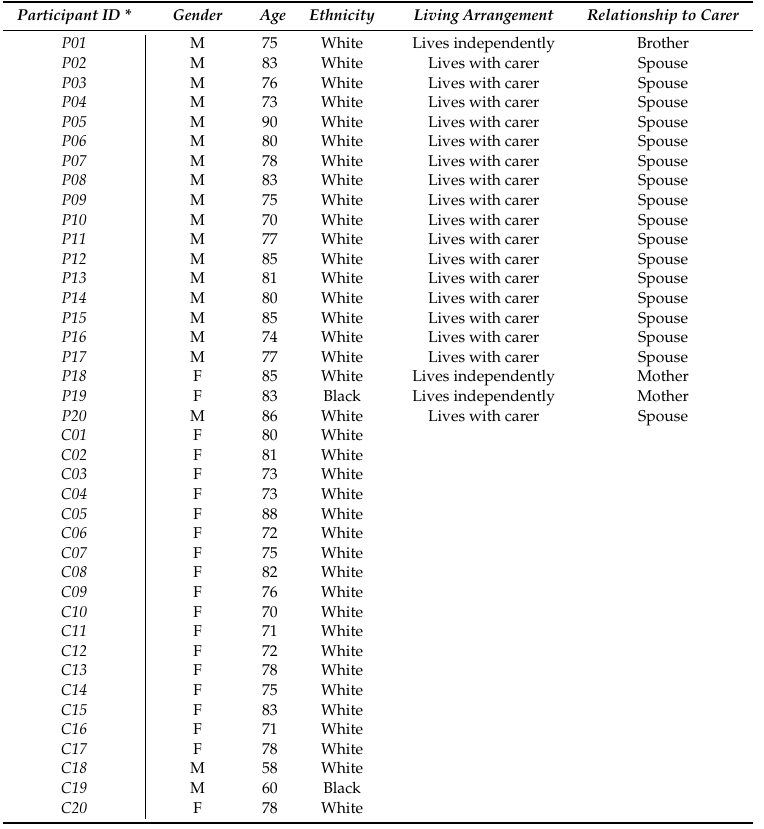
Table 1. Characteristics of